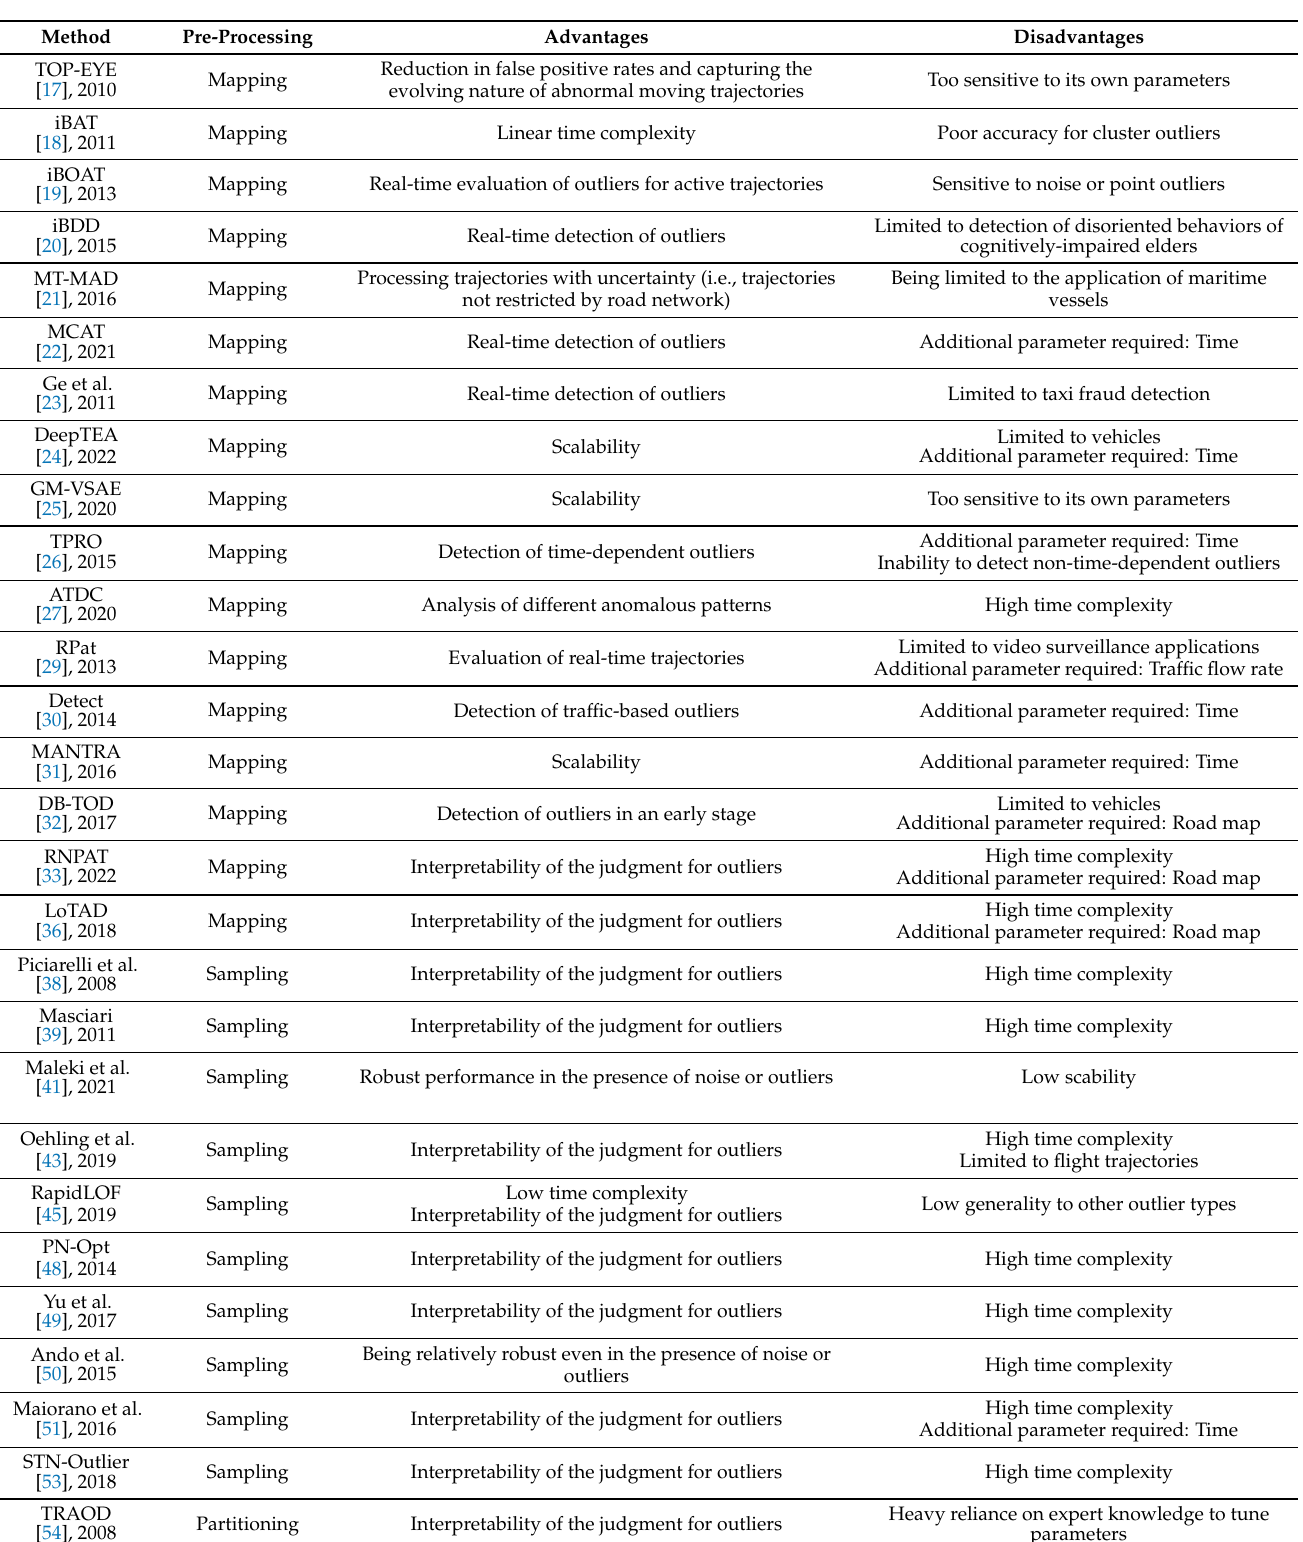
Table A1. Advantages and disadvantages of trajectory outlier detectors introduced in Section 1 and the proposed